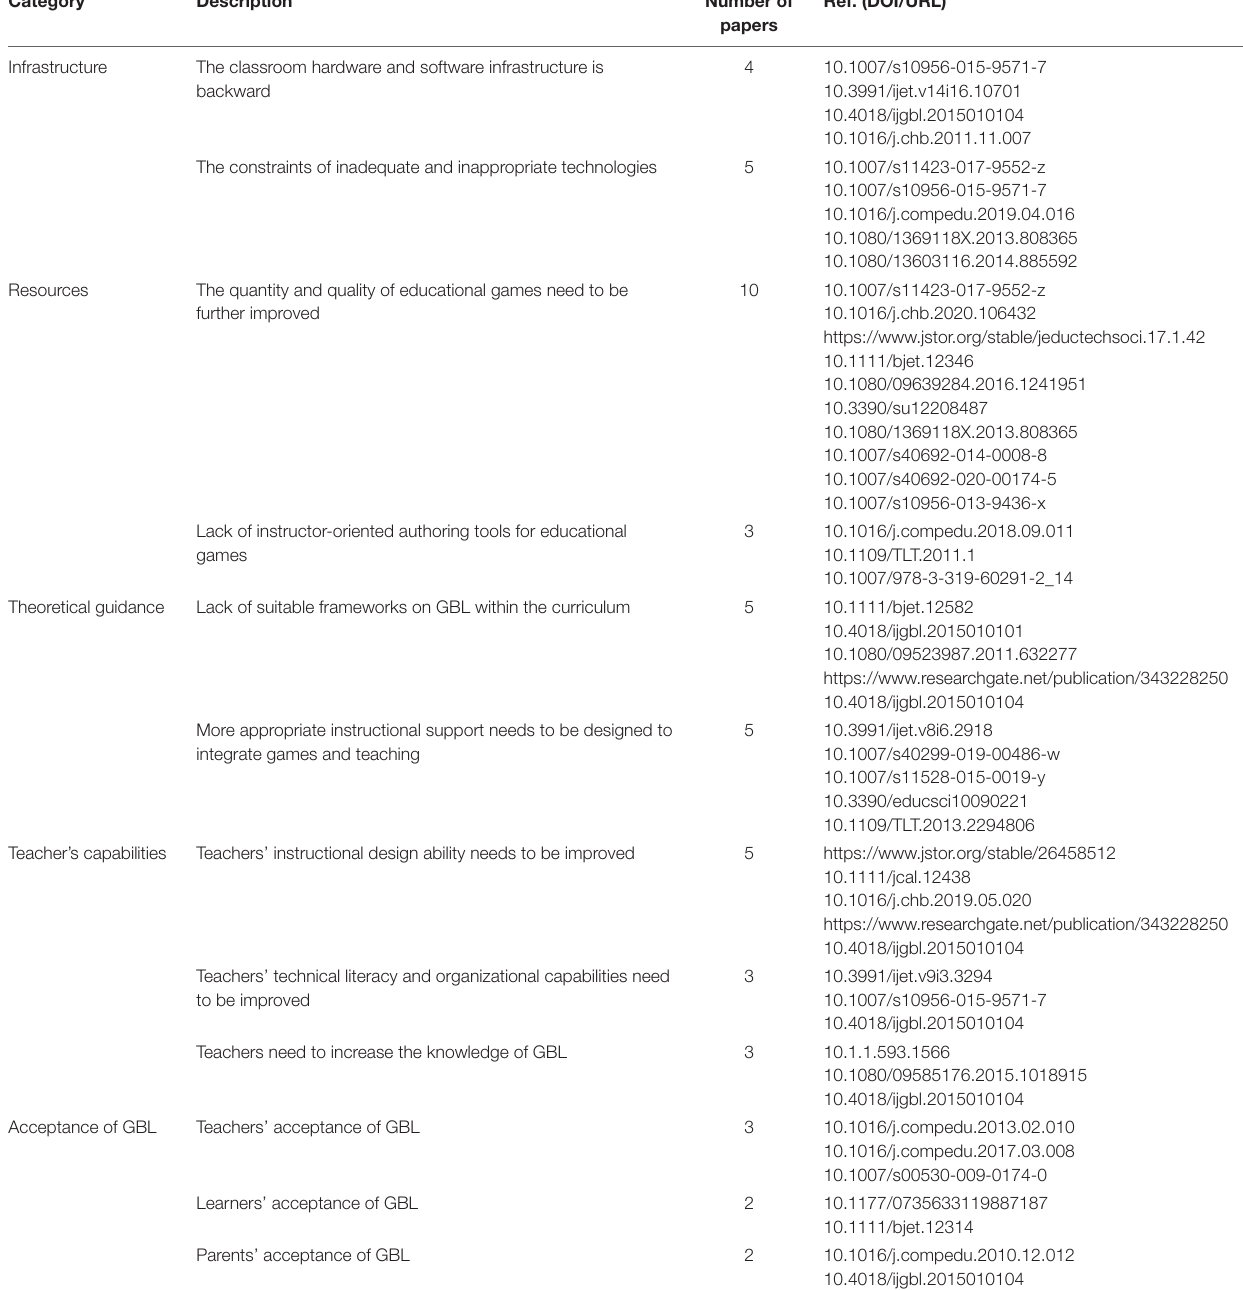
TABLE 3 | The difficulties of implementing GBL in